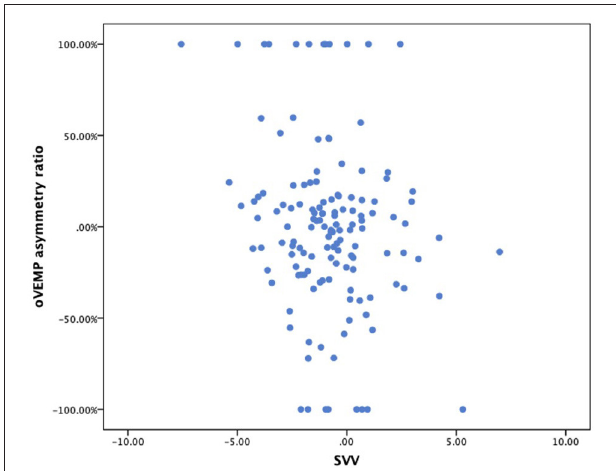
FIGURE 2 | Scatterplot of SVV (x-axis) vs. oVEMP asymmetry ratio (y-axis). SVV, subjective visual vertical; oVEMP, ocular vestibular evoked myogenic